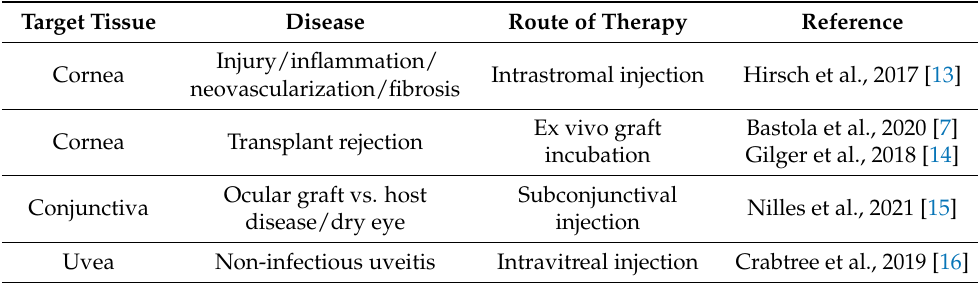
Table 1. Publications or abstracts on the use of AAV-HLA-G in the eye.